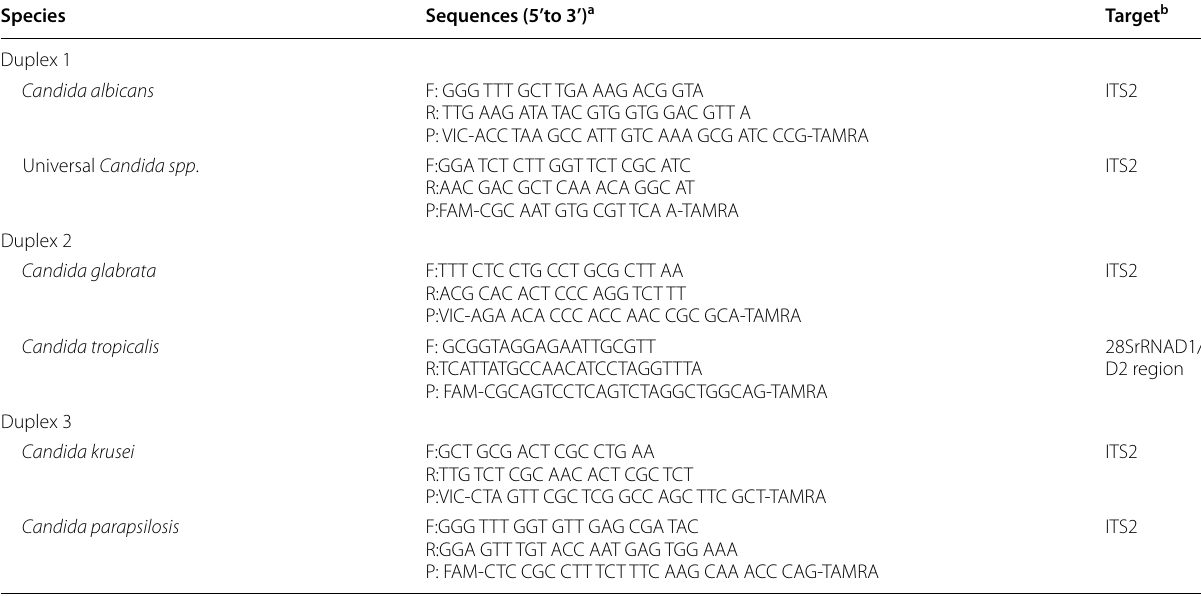
Table 1 Candida TaqMan primer and probe